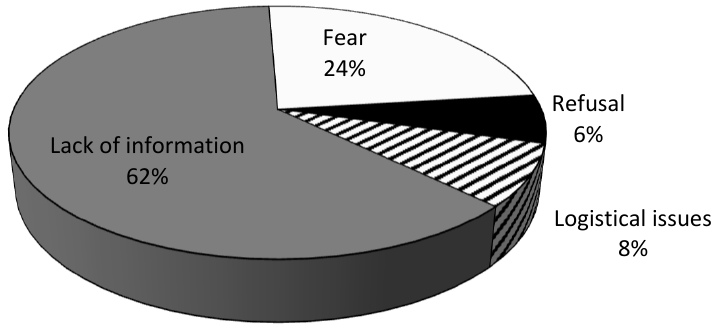
Figure 2. Main reason reported by parents or guardians for not vaccinating their children or adoles ‐ cents against HPV (n = 177).